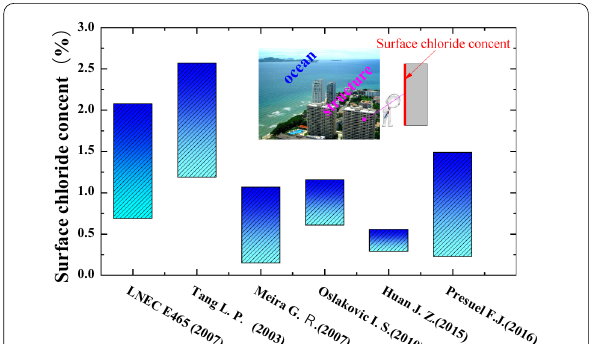
Fig. 1 Statistics of surface chloride ion